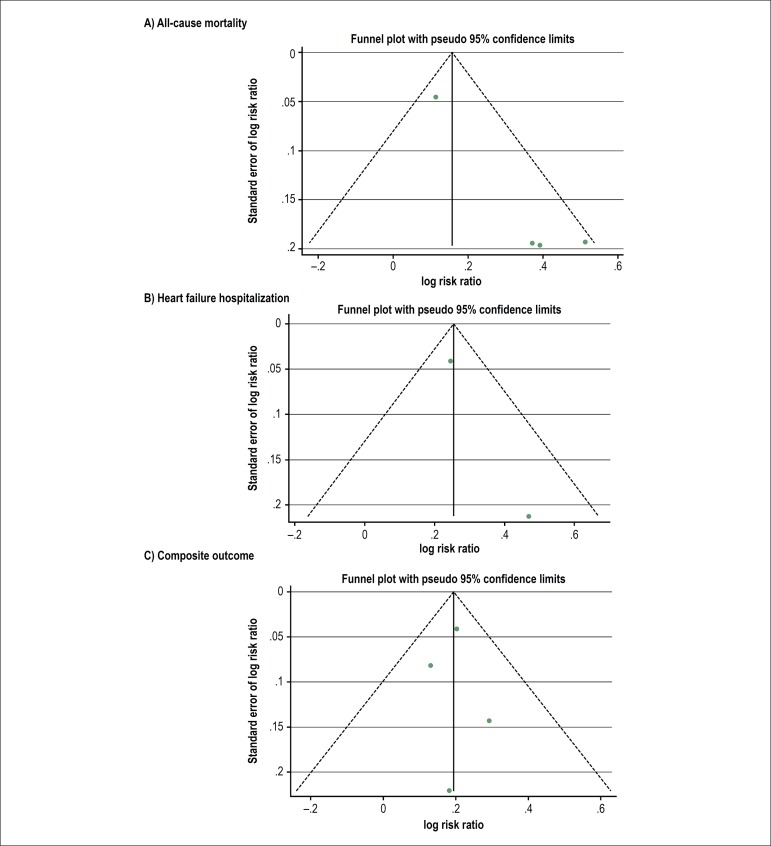
Funnel plot of prolonged PR and risk of all-cause mortality (3A), HF
hospitalization (3B), and composite outcome (3C). Circles represent
the observed published studies.